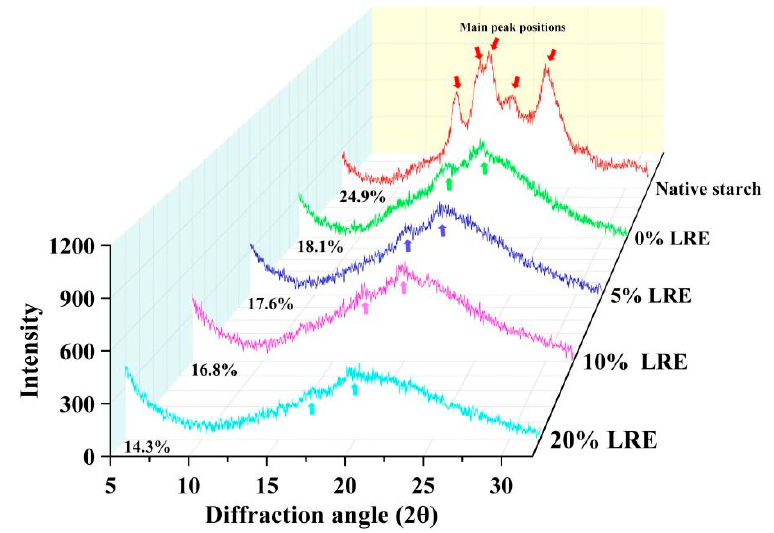
Figure 3. Wide-angle X-ray diffraction pattern of wheat starch gel with different concentrations of LRE. LRE: Ligustrum robustum (Rxob.) Blume extract.